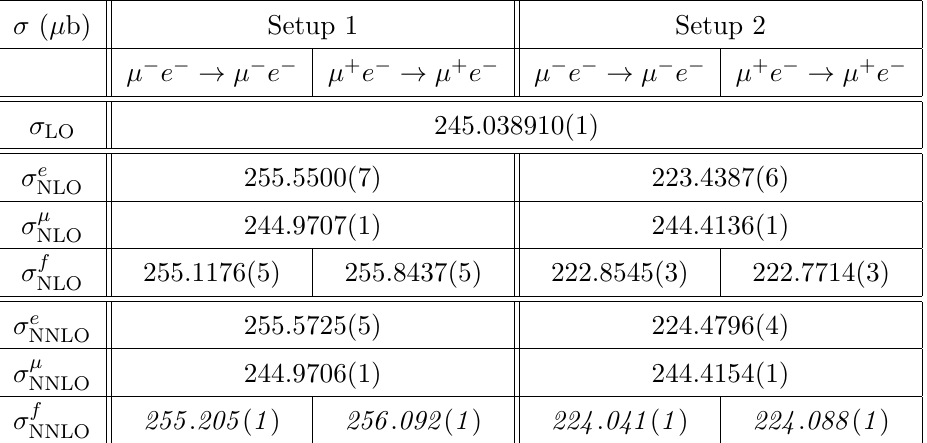
Table 1 . Cross sections (in (cid:22) b) and relative corrections for the processes (cid:22) (cid:0) e (cid:0) (cid:22) + e (cid:0) (cid:22) + e (cid:0) , in the two di(cid:11)erent setups described in the text. The symbols (cid:27) e=(cid:22)=f ! the cross sections with corrections along the electron line only, along the muon line only and the full approximate contributions, respectively, with the perturbative accuracy given by the subscripts. The digits in parenthesis correspond to 1 (cid:27) MC error. Italicized numbers in the last row indicate that in this cross-section the full two-loop amplitude is approximated as described in section